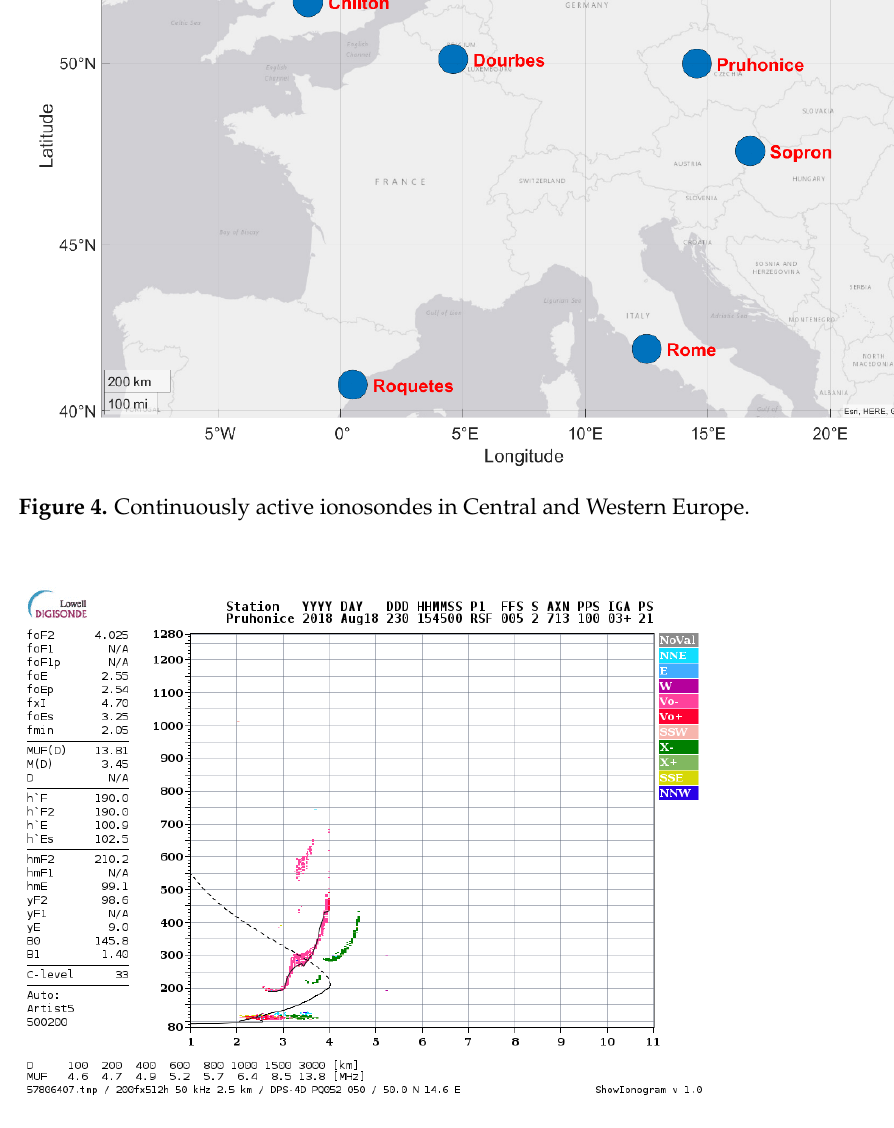
Figure 4. Continuously active ionosondes in Central and Western Europe.